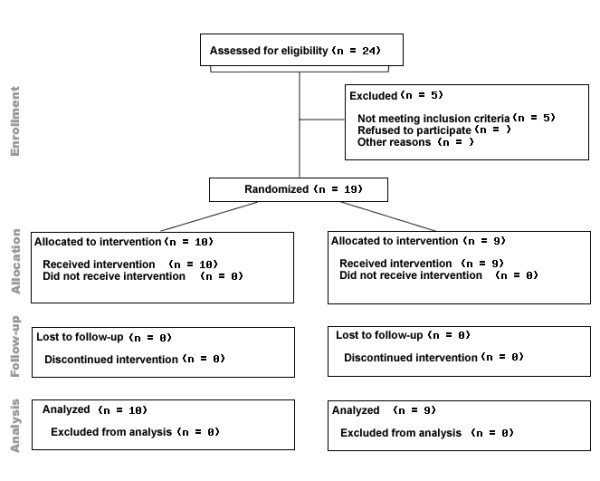
CONSORT flowchart.